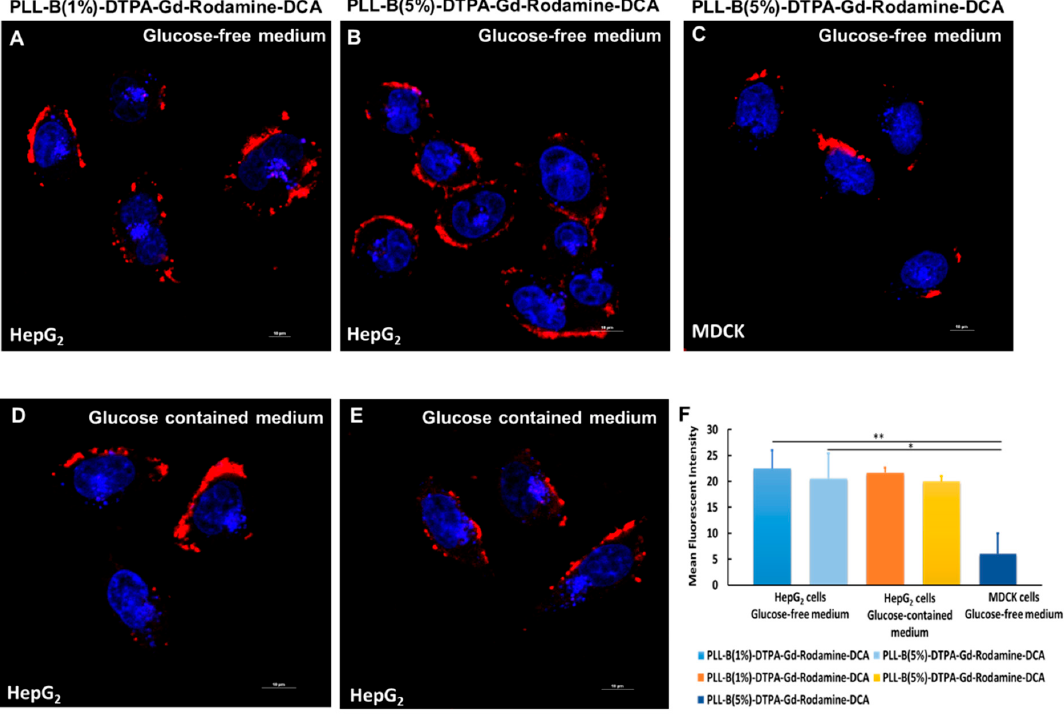
Figure 4. Intracellular colocalization of ( A ) PLL-B(1%)-DTPA-Gd-Rodamine-DCA on HepG 2 cellsin glucose-free medium; ( B ) PLL-B(5%)-DTPA-Gd-Rodamine-DCA with cytomembrane on HepG 2 cells in glucose-free medium; ( C ) PLL-B(5%)-DTPA-Gd-Rodamine-DCA on MDCK cells in glucose-free medium; ( D ) PLL-B(1%)-DTPA-Gd-Rodamine-DCA on HepG 2 cells in glucose-containing medium; ( E ) PLL-B(5%)-DTPA-Gd-Rodamine-DCA on HepG 2 cells in glucose-containing medium (Blue: DRAQ5; Red: PLL-B(1%)-DTPA-Gd-Rodamine-DCA/PLL-B(5%)-DTPA-Gd-Rodamine-DCA); ( F ) Image-based quantification of mean fluorescent intensity statistic using Image J software. Data represent the average fluorescent intensity of each group. * p < 0.05, ** p < 0.01.